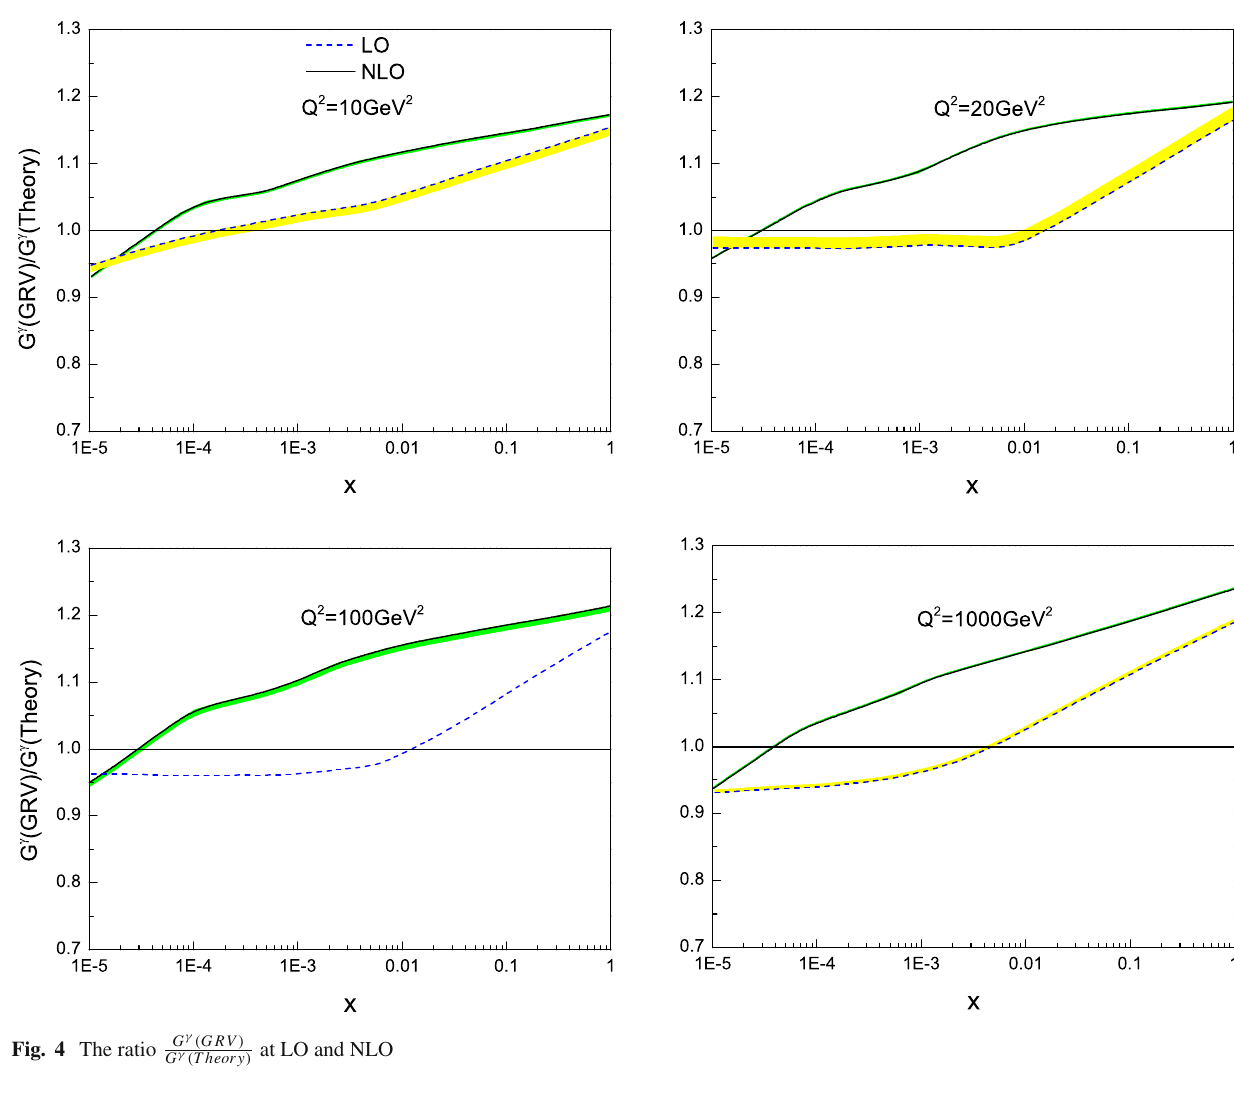
γ ( GRV ) at LO and G γ ( Theory )